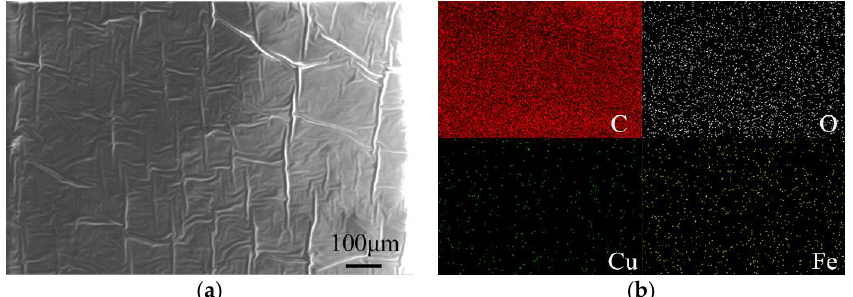
Figure 7. SEM results on the surface of LCG grease after the wear test: ( a ) SEM micrograph, and ( b ) mapping scanning results on ( a ).